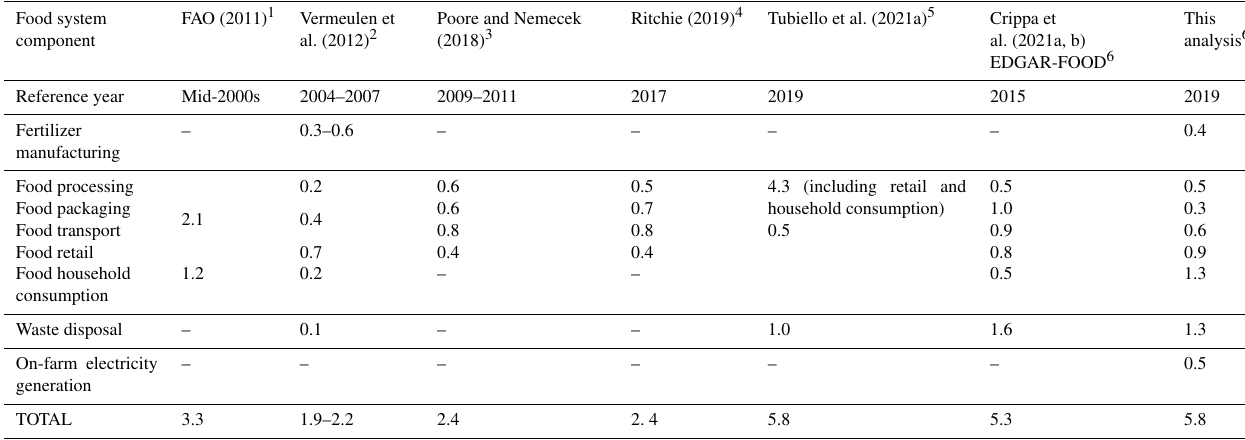
Table 4. Overview of pre- and post-food production GHG emission estimates from selected studies, GtCO 2 eq. Adapted from Tubiello et al. (2021b).